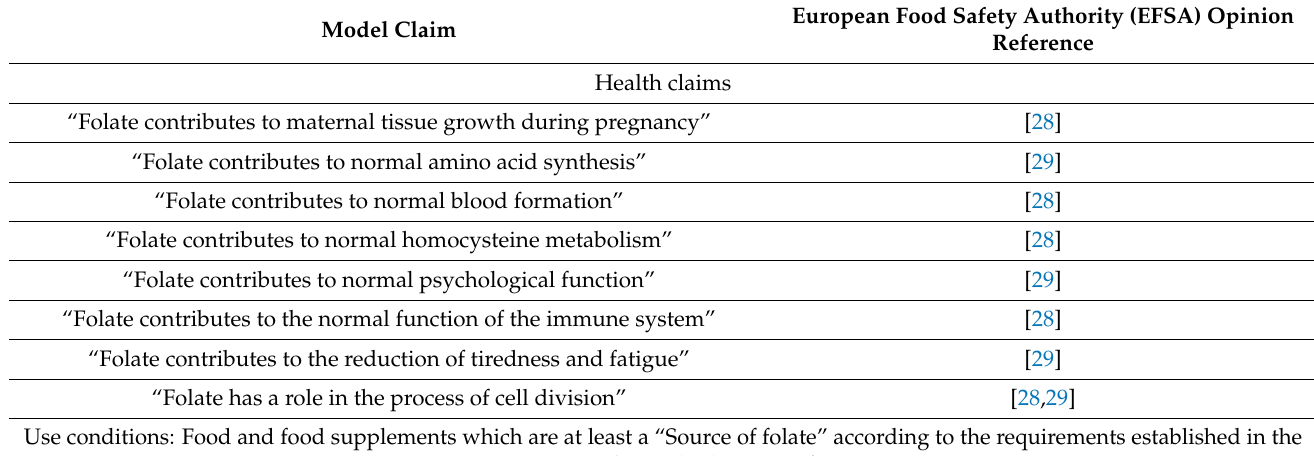
Table 1. Health-related claims approved for folic acid according to the European